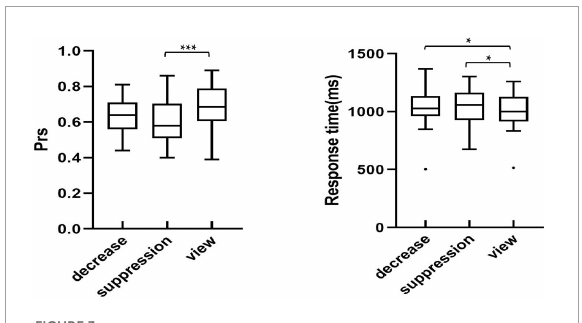
FIGURE3 Recognition performance across conditions in the test phase. * p < 0.05, ** p < 0.01, *** p < 0.001.